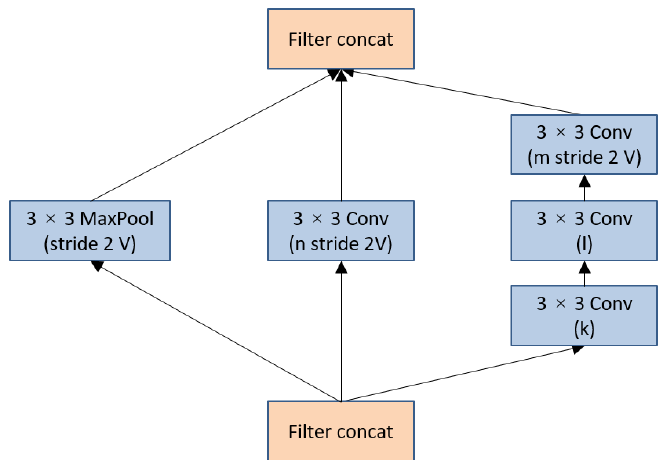
Figure 7. The schema of inception-v4 block for 35 × 35 to 17 × 17 reduction module. It was first referred in each dense block in Figure 6. The k, l, m, n numbers stand for filter bank sizes, with the values corresponding to 192, 224, 256, 384. (comcat is short for concatenation, and conv is short for convolution).